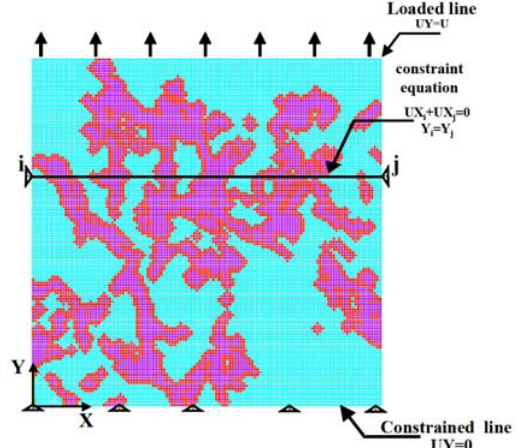
Fig. 5. Meshing and loading conditions for a composite mi- crostructure under three-phase